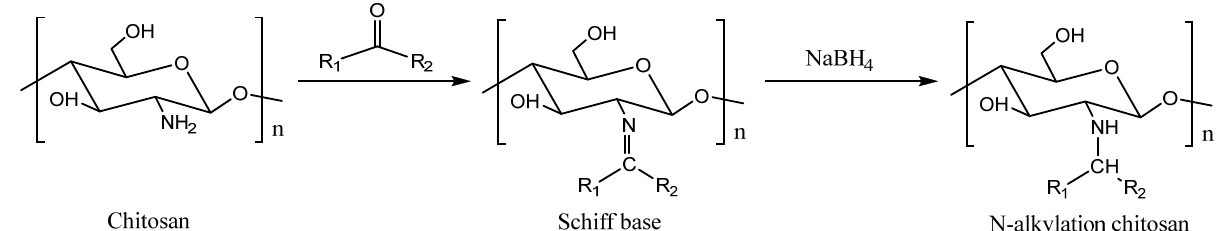
Figure 5. Preparation of N-alkylated chitosan by the Schiff base method. Table 6. Antifungal properties of some alkylated chitosan derivatives.